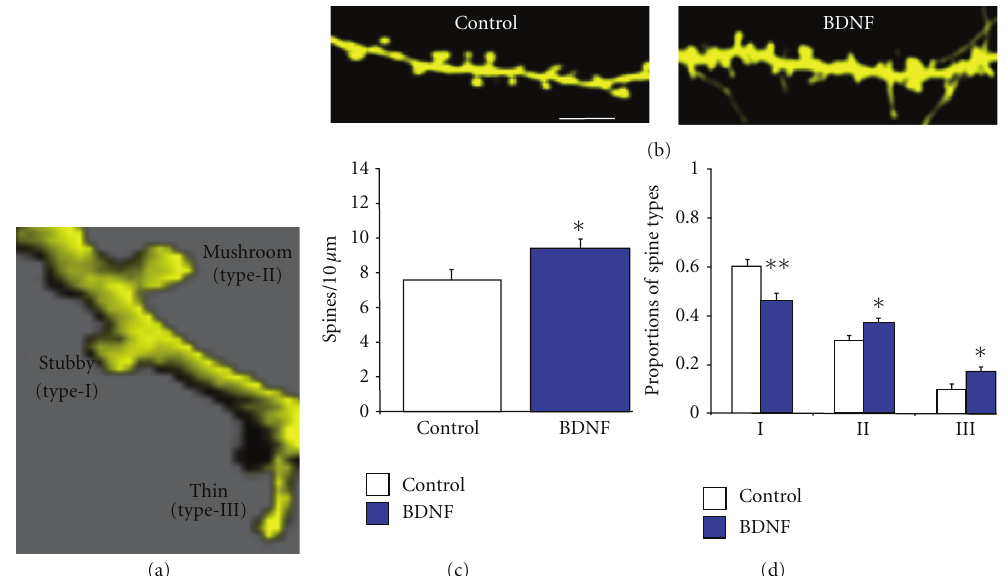
Figure 1: BDNF increases dendritic spine density and a ff ects the proportion of morphological spine types. (a) Dendritic segment of a CA1 pyramidal neuron that was volume-rendered to illustrate individual spine geometrical dimensions and examples of di ff erent spine types. (b) Representative examples of dendritic segments of CA1 pyramidal neurons maintained in serum-containing media (SM) and treated with BDNF (250ng/mL) for 48hrs (scale bar represents 2 µ m). (c) Dendritic spine density expressed per 10 µ m of apical dendrite. (d) Proportion of each morphological type of dendritic spine, expressed as a fraction of the total spine population. ∗ P < 0 . 05 and ∗∗ P < 0 . 01, after an unpaired Student’s t